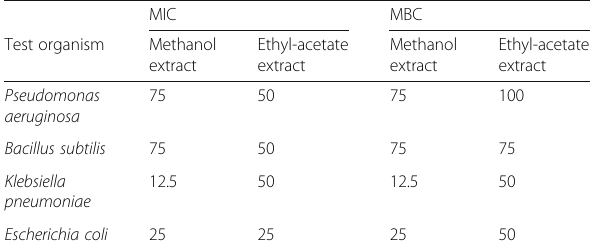
Table 8 Anti-inflammatory effects of crude methanol extract of Azanza garckeana against egg albumin induced paw oedema Vol. of hind paw(cm 3 ) at different times (min)